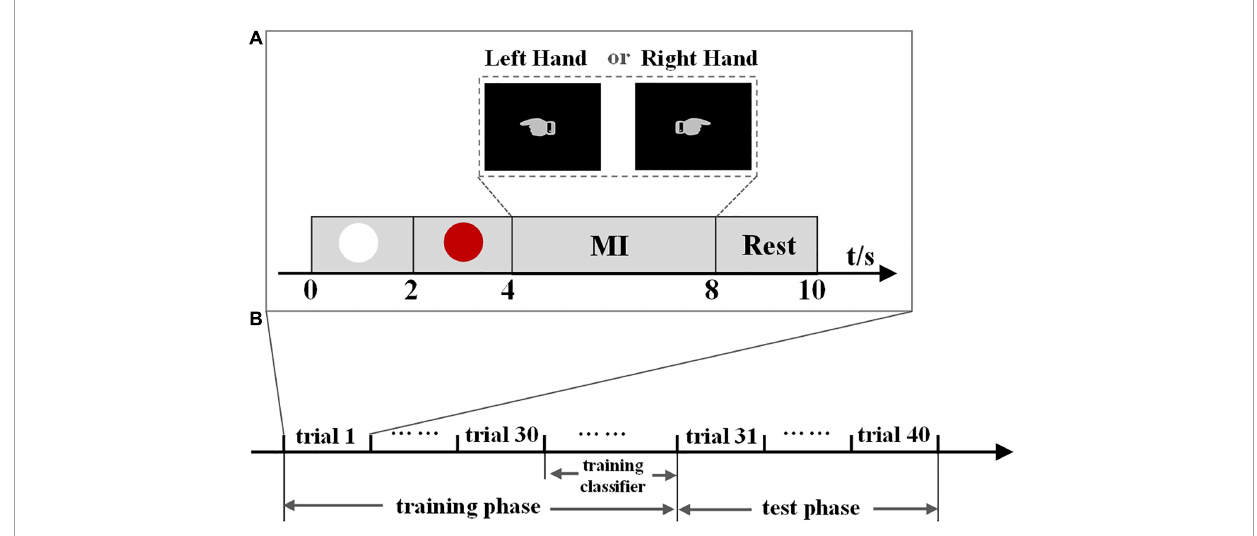
FIGURE1 (A) Timing of a trial paradigm of experiment one and experiment two. A white circle is displayed for 2 s at the beginning, then a red circle appears 2 s later, reminding the subject to be prepared for an experiment task. From the 4 to 8 s, the subject performs the MI task. A hand pointing to the left indicates the left-hand MI task and pointing to the right indicates the right-hand MI task. In the test phase of experiment two, subjects were informed of the output after each MI task. Finally, the subject is asked to keep a resting state for 2 s. (B) Experiment phases of experiment two. We use the proposed methods to train a classifier in the training phase, then evaluate its performance in the test phase.